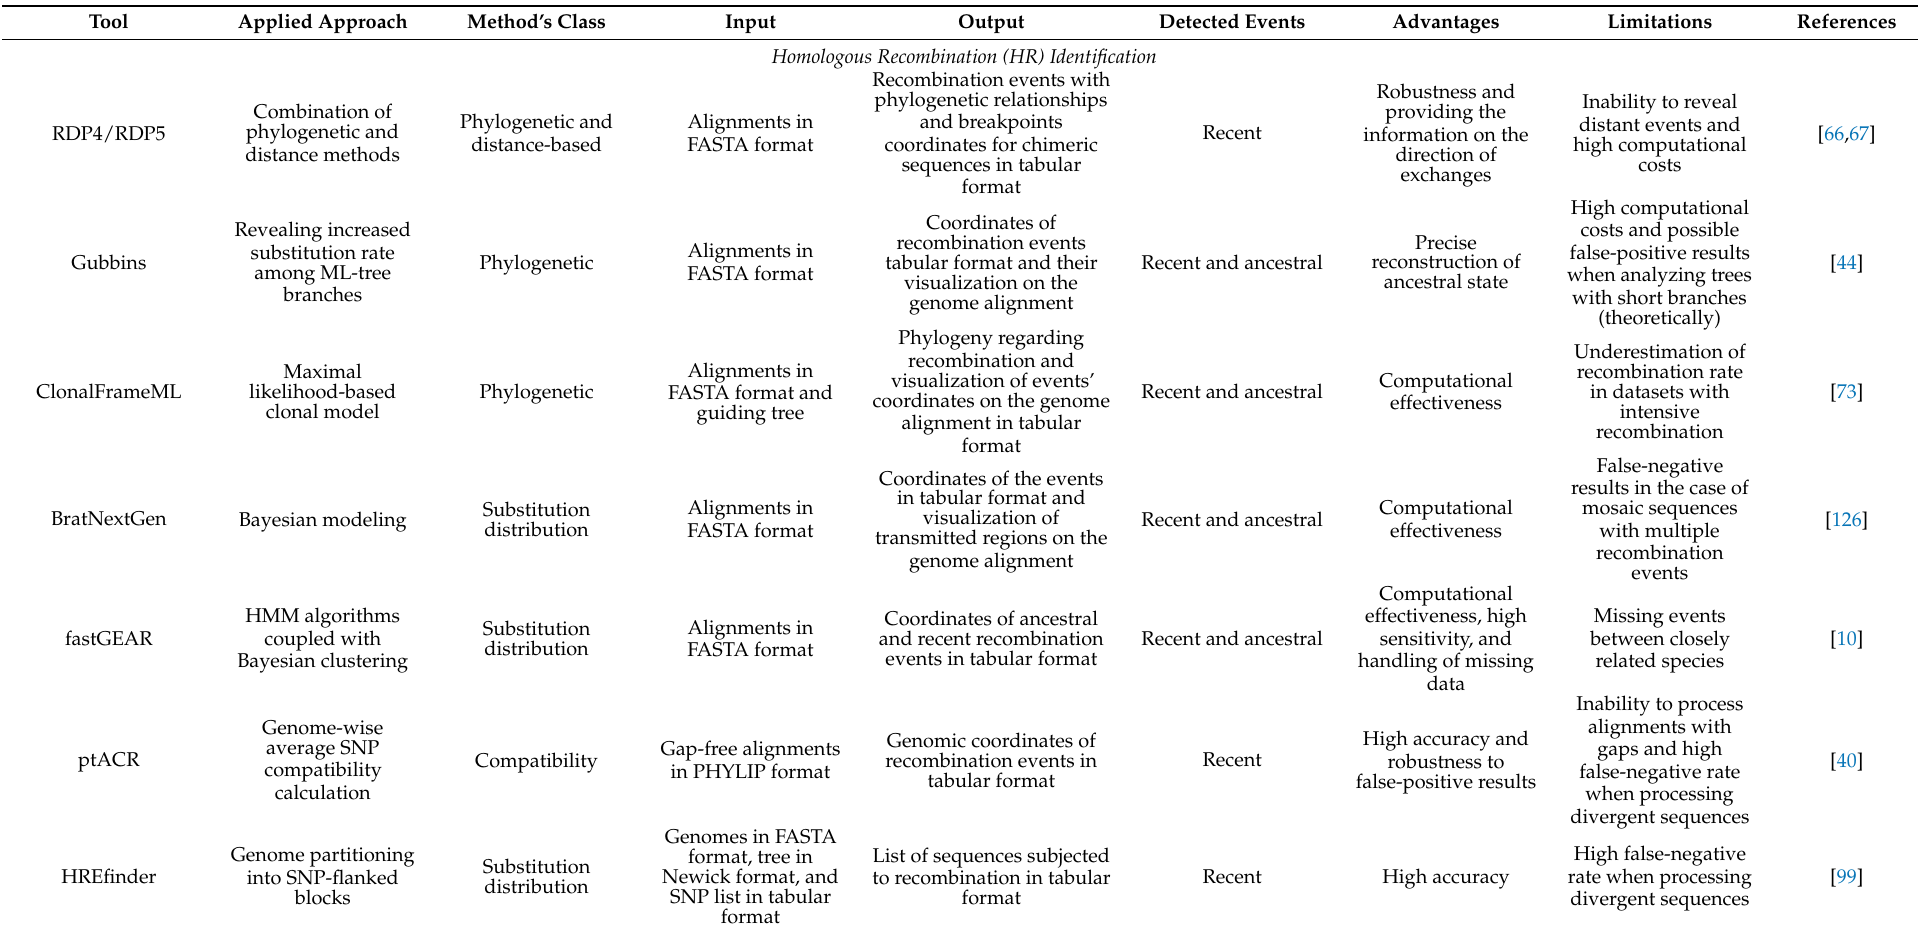
Table 1. Current bioinformatics tools for detecting homologous recombination and horizontal gene transfer in genetic data. The table summarizes tools’ properties in terms of algorithms applied, input files and output results, type of detected events, advantages, and